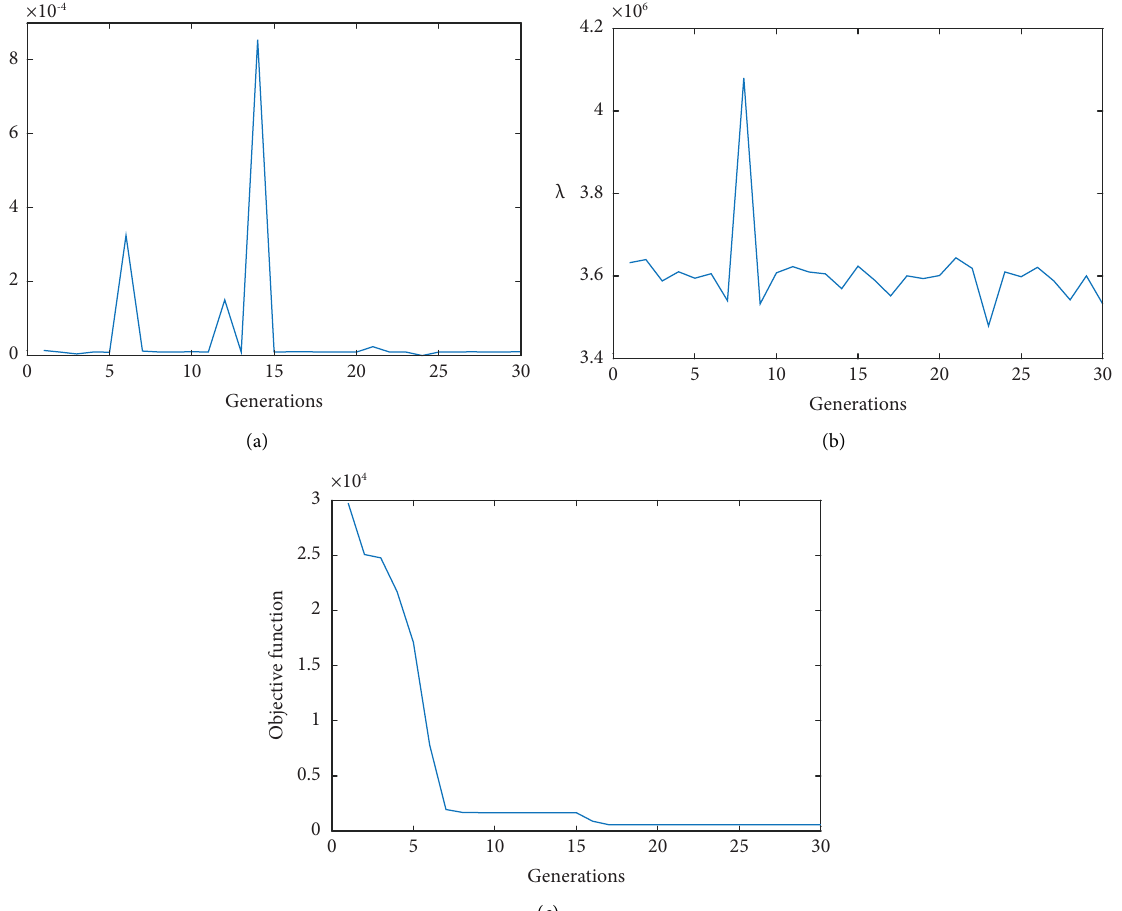
Figure 18: (a and b) Te fnal search of parameters T and λ and (c) convergence graph of objective